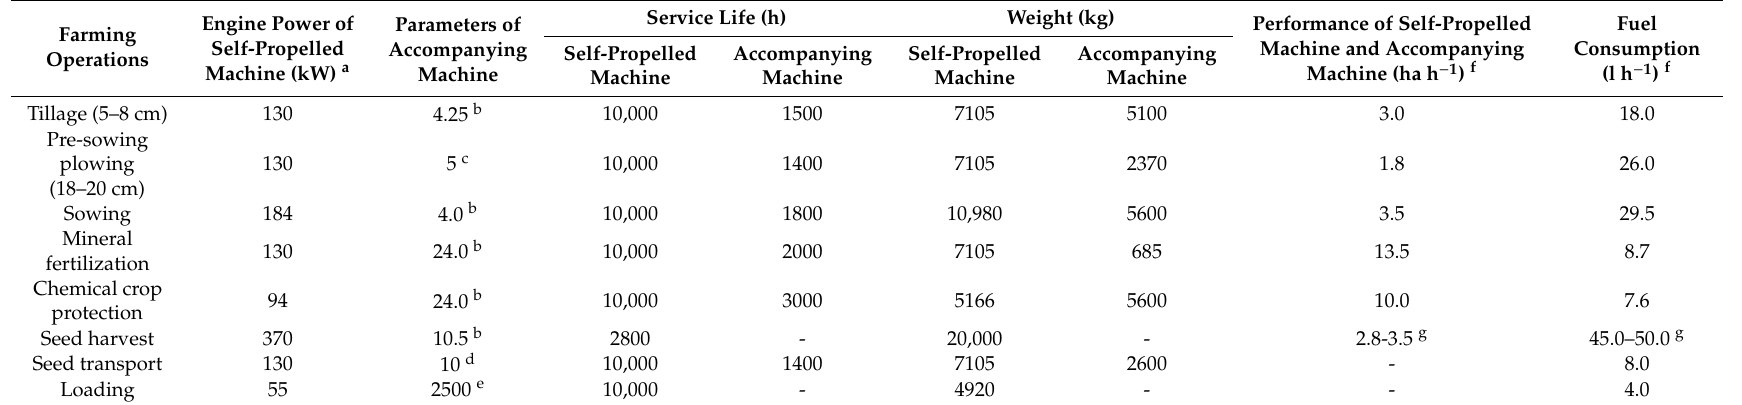
Table 2. Technical parameters of agricultural machines, machine performance and fuel consumption during winter oilseed rape